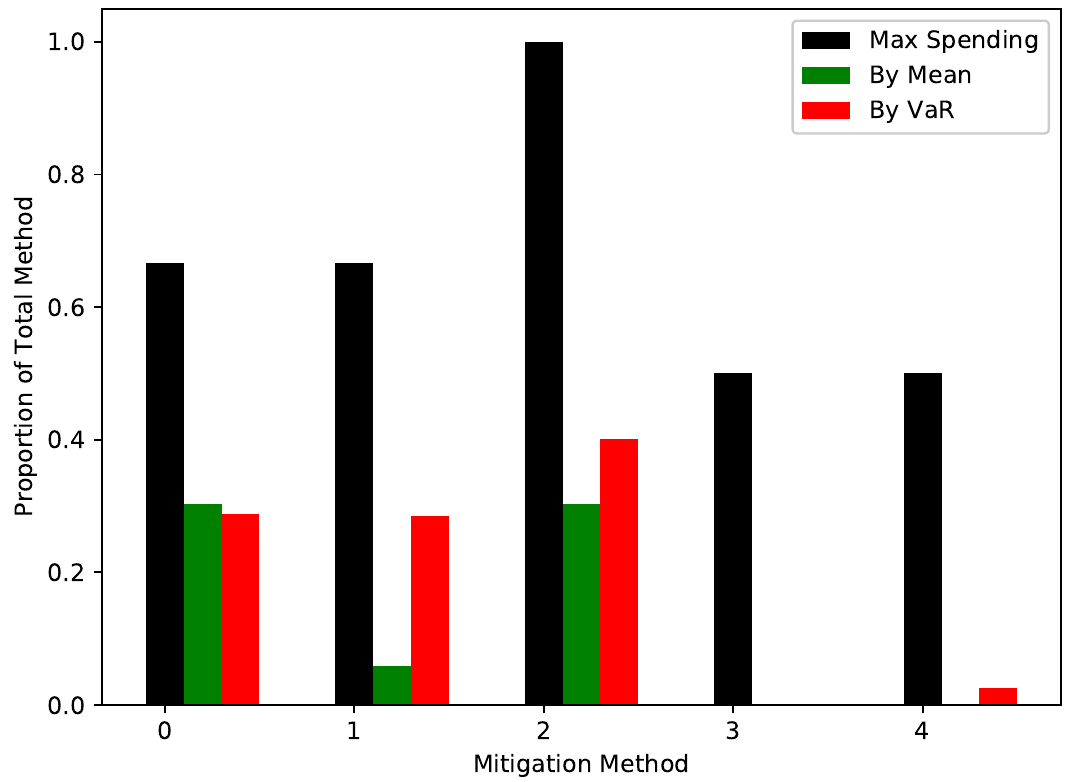
Figure 8. The output spendings for the five categories, from Application Whitelisting being 0 to Personnel Management as 4, after optimising to minimise the mean (in green) and to minimise the VaR at the α = 0.01 level (in red). The maximum spendings in black give the ratios ω m / z , the ratio of the cost of the mitigation to the available budget; this is the proportion of the budget needed to purchase this mitigation in